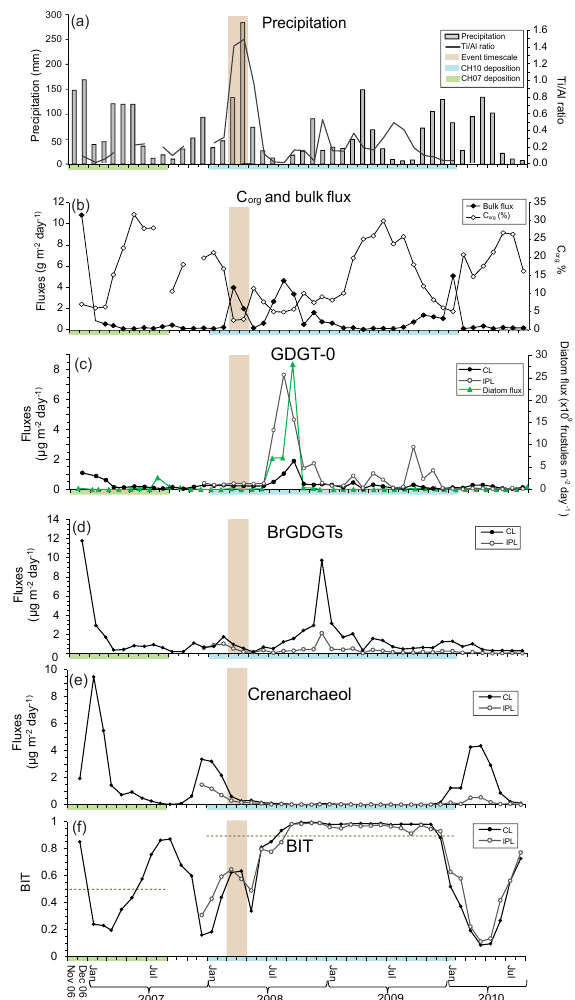
Figure 4. Fluxes and GDGT parameters of approximately monthly sediment-trap samples of settling particles, from 18 November 2006 to 31 August 2010. (a) Monthly precipitation over the 0.5 ◦ × 0.5 ◦ grid which includes Lake Challa, from the Global Precipitation Cli- matology Centre data set, version 6 (GPCC-v6; Schneider et al., 2014), and the Ti / Al ratios of settling mineral particles (Wolff et al., 2014); also indicated are the episodes of heavy rainfall in March–April 2008 and the estimated period covered by the 0–1cm interval of surface-sediment samples CH07 and CH10. (b) Fluxes of bulk sedimenting particles and bulk percent organic carbon (%C org ) content. (c) Settling fluxes of diatoms and of the IPL and CL frac- tions of GDGT-0. (d) IPL and CL brGDGTs. (e) IPL and CL cre- narchaeol (GDGT-V). (f) IPL and CL BIT index, with dashed hori- zontal lines representing the average CL BIT indices of surface sed- iment deposited over the time periods corresponding to CH07 and CH10. In panels (c) – (f) , geochemical data from 18 November 2006 to 1 December 2007 are by Sinninghe Damsté et al. (2009) and data from the following months until 31 August 2010 are by Buckles et al.